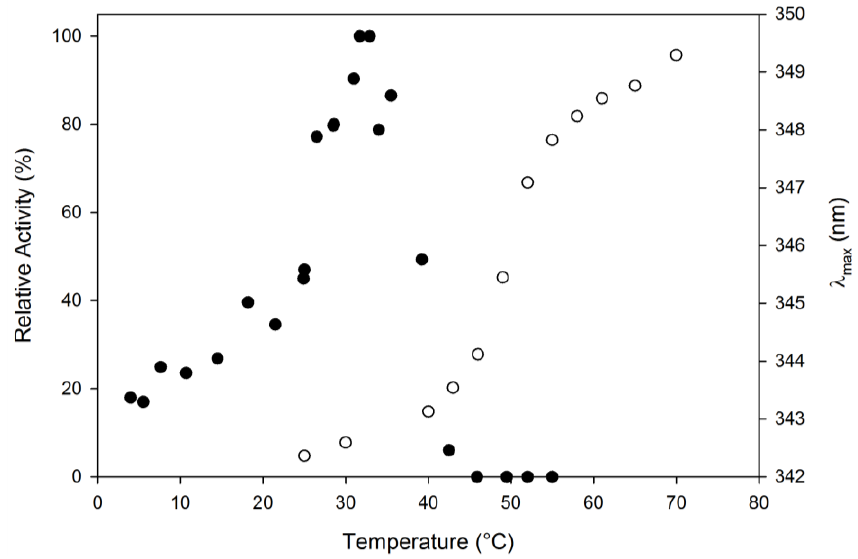
Figure 4. Influence of temperature on the MHlip activity ( (cid:120) ). The enzyme was pre-incubated for 5 min at temperature ranging from 4 to 55 °C. Enzyme activity was determined under standard conditions on pNPA, at pH 8.0. The activity measured at 30 °C was taken as 100%. MHlip thermal denaturation following the maximum of fluorescence ) in a thermal gradient ranging from 20 to 80 °C emission ( (cid:79) max